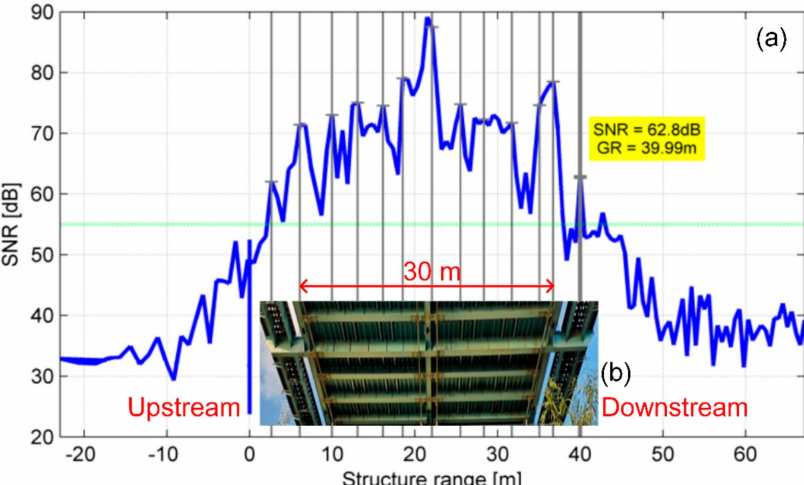
Figure 16. ( a ) Structure range profile of the bridge deck and the gray lines indicate the radar bins displacement; ( b ) photograph from the view S3 in Figure 4, which shows the bottom of the bridge deck illuminated by the